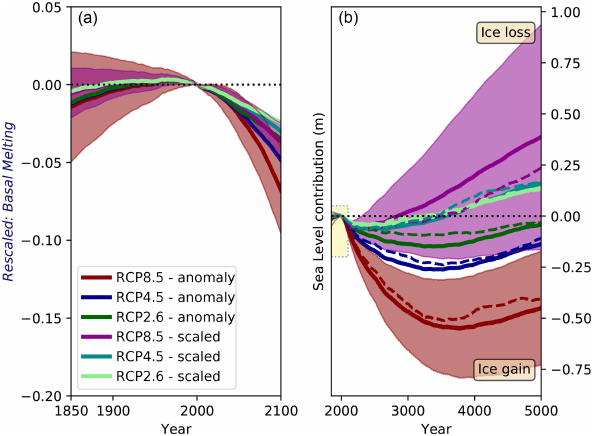
Figure E6. The simulated sea level considering the correction as defined by Eq. (D8) and Fig. E5. The sea level (in meters) is computed relative to the simulated sea level for each individual simulation at the year 2000 as in Fig. 8. The reader is referred to Fig. 8 for further